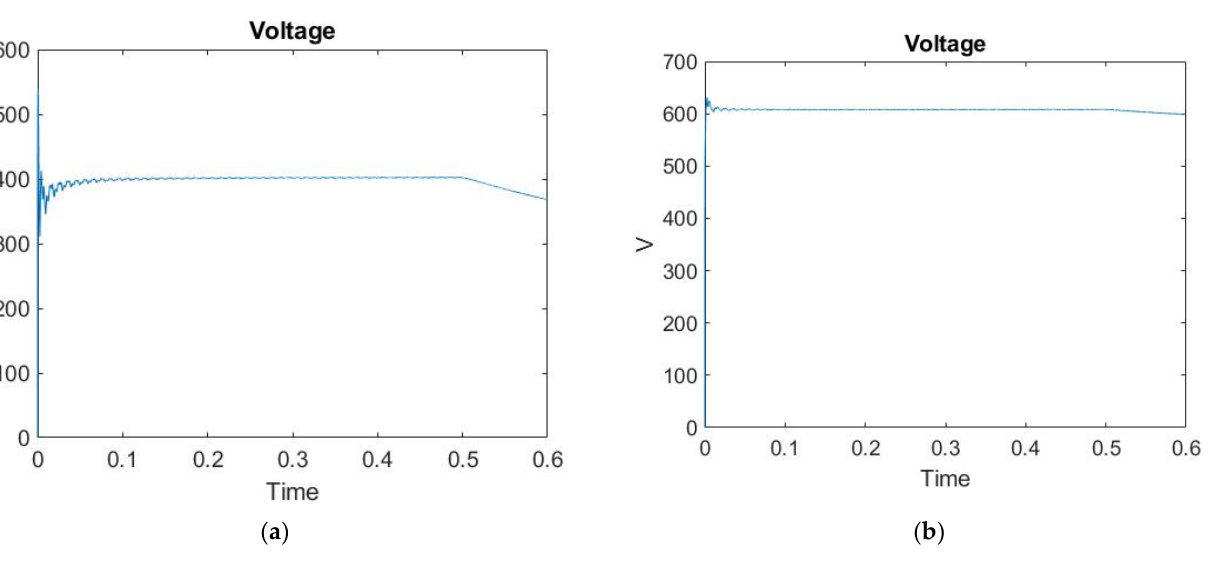
Figure 14. Voltage drop at the input ( a ) and at the inverter ( b ). The voltage drops at 0.5 s. After the fall, the supercapacitor unit begins to discharge and is used as a buffer source of electricity. At the same time, the characteristics that occurred in the drive were recorded—Figure 15.